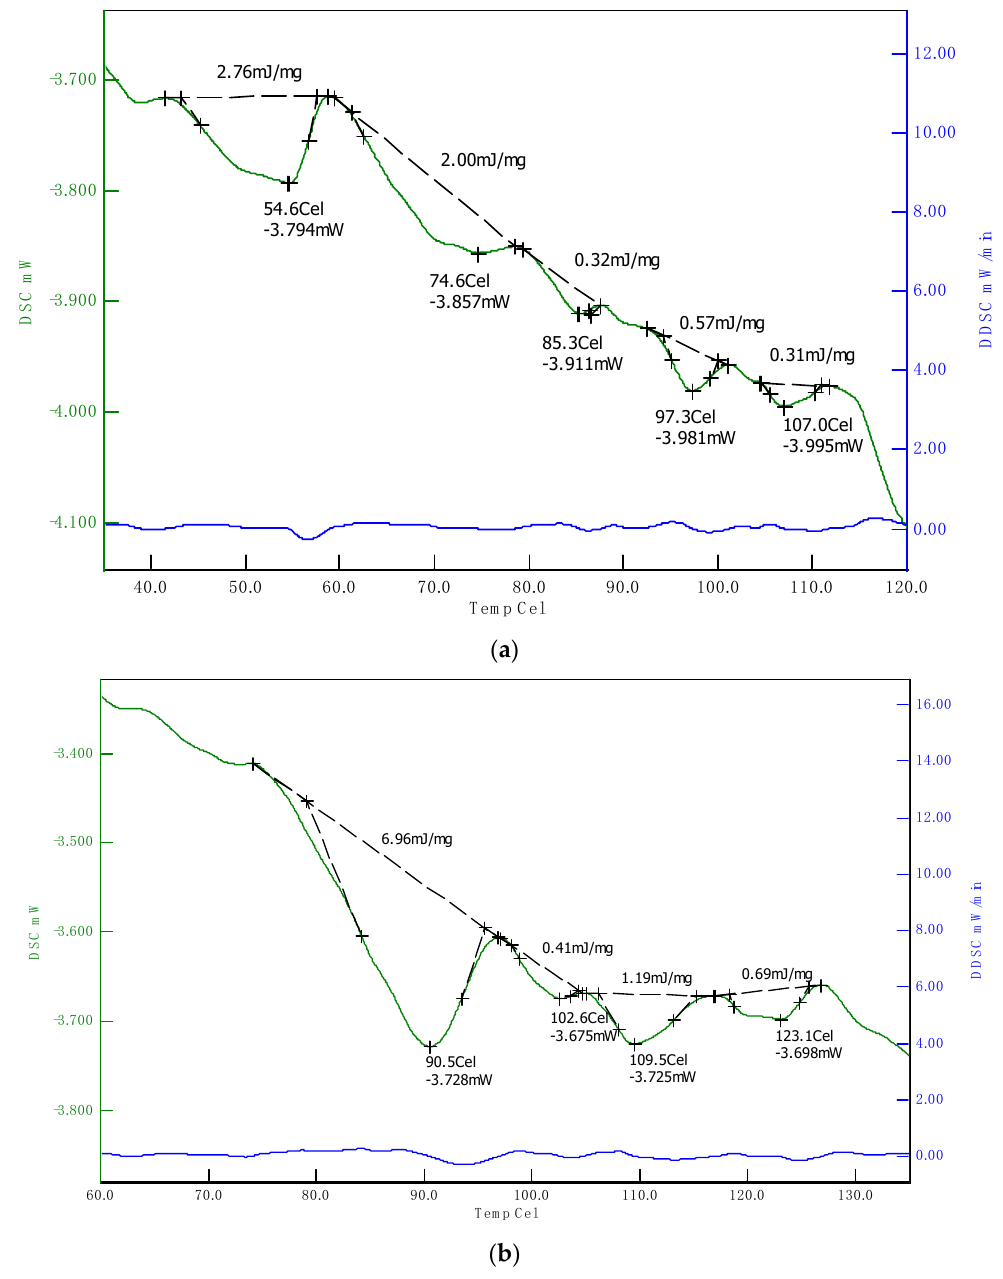
Figure 5. DSC thermograms for ( a ) SPI; and ( b )HPC.